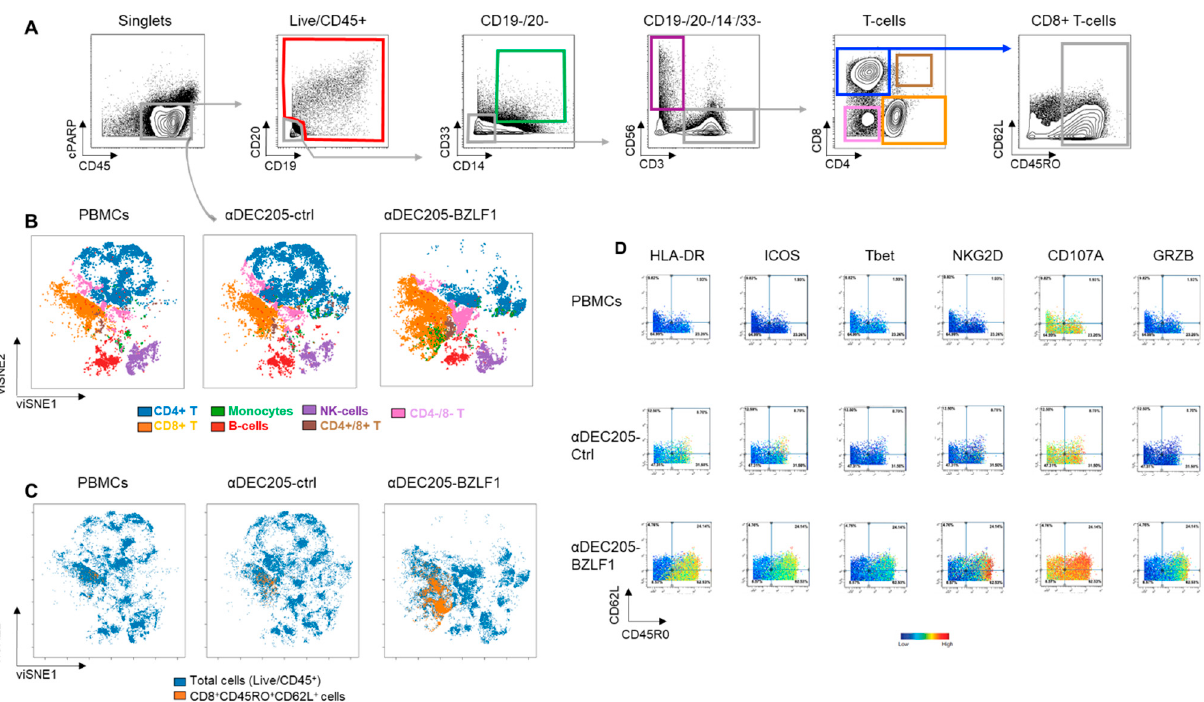
Figure 3. Immunome phenotype of cells generated on the DC: PBMC CoCx, by mass cytometry: ( A ) Gating scheme; ( B ) viSNE immunome maps that show distinct clusters representing different immune cell types; ( C ) Overlaid viSNE maps of total cells and CD8+CD45+CD62L+ effector cells; ( D ) Biaxial plots of CD8+ T-cells with CD45RO on the X -axis versus CD62L on the Y -axis. Evens on the biaxial plots colored according to the intensity of expression of the indicated markers.